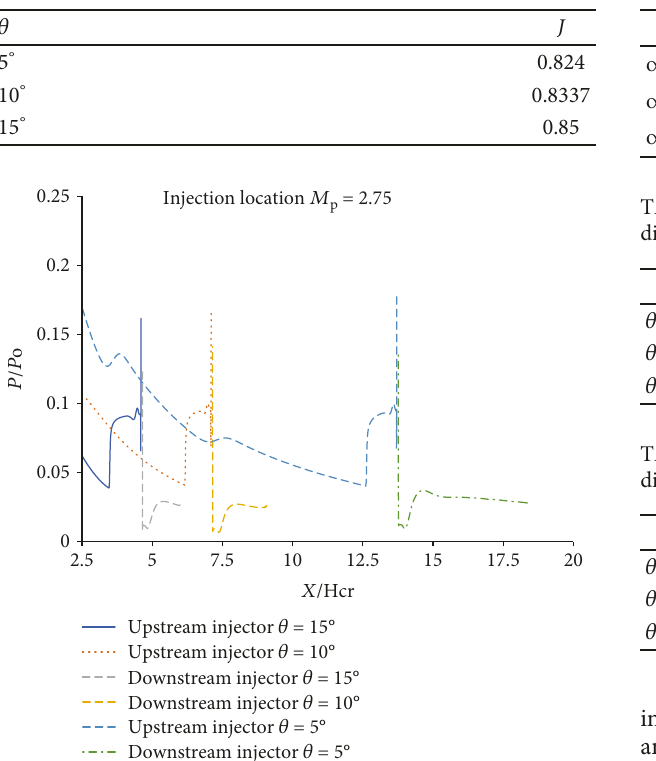
Table 6: Momentum fl ux ratio J with divergence half angle at = 2 75 . M p